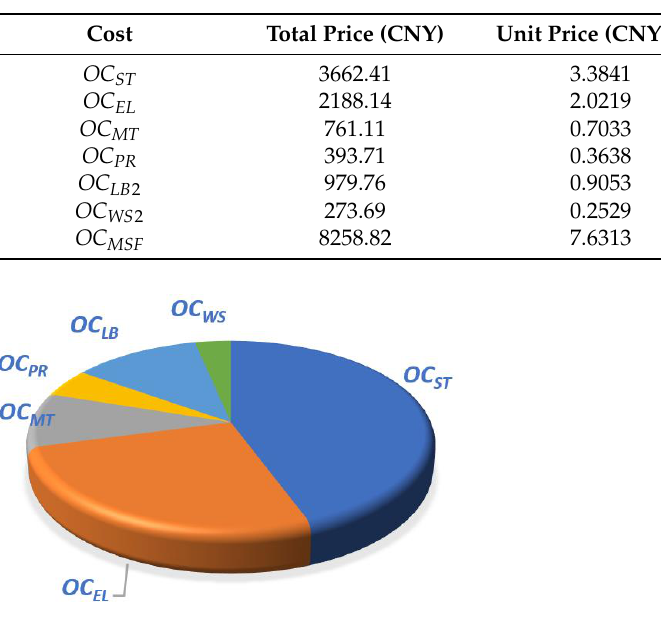
Table 4. OT-MSF system cost ratio.